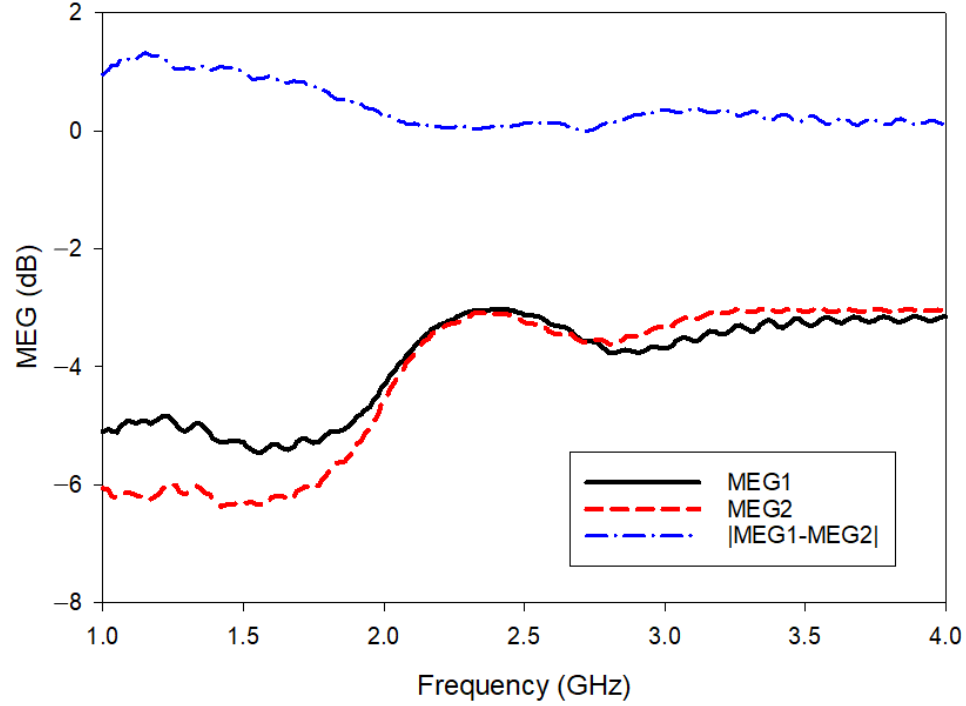
Figure 15. MEG results for MIMO-RIS-EBG.